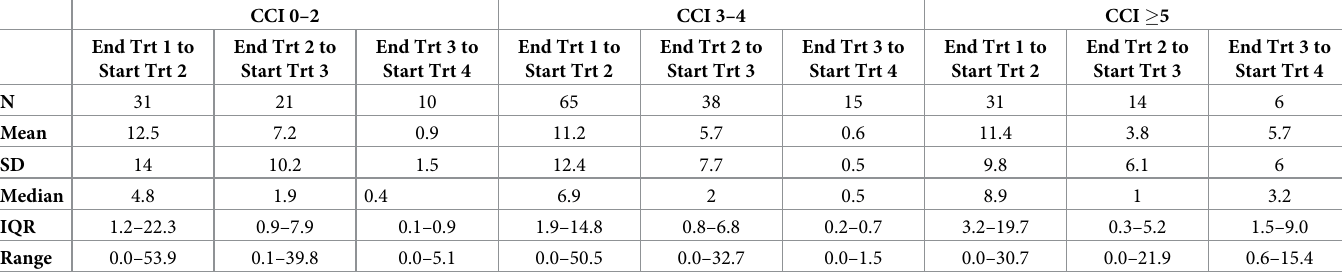
Table 7. Treatment-free interval in months according to co-morbidities following first-line and subsequent lines of therapy.